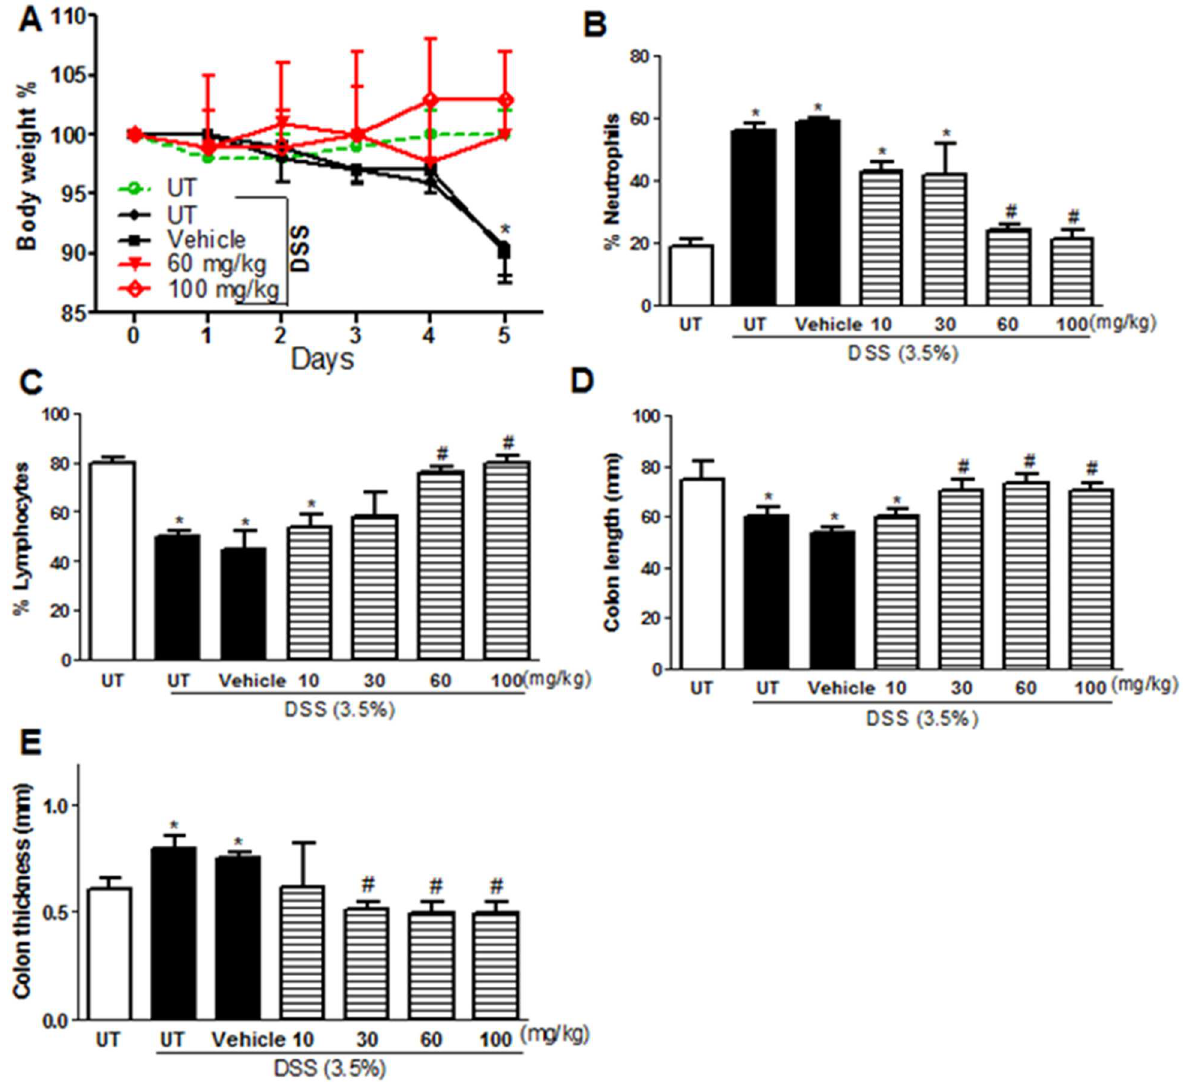
Fig 1. Effect of E121 treatment on colitis severity. Panel A shows % body weight changes in DSS treated mice alone or receiving vehicle(solid circles and squares, black lines), or E121 treated mice (red lines)compared to untreated(UT) mice receivingtap water only (open circle, hatchedgreen line). PanelsB and C show % of circulatingneutrophilsand lymphocytes respectivelydetermined at day 5 post colitis inductionin DSS treated mice alone or receivingvehicle(solid bars) or E121 treated mice (hatched bars) comparedto UT group (open bars). Colonlength (panelD) and thickness (panelE) was determinedin all groups. Histobars represent means ± SEM for 6 mice in each group. Asterisks denote significantdifference from UT mice with p < 0.05( * ), # denotessignificantdifference from DSS alone and DSS/i.p vehicletreated mice with p <